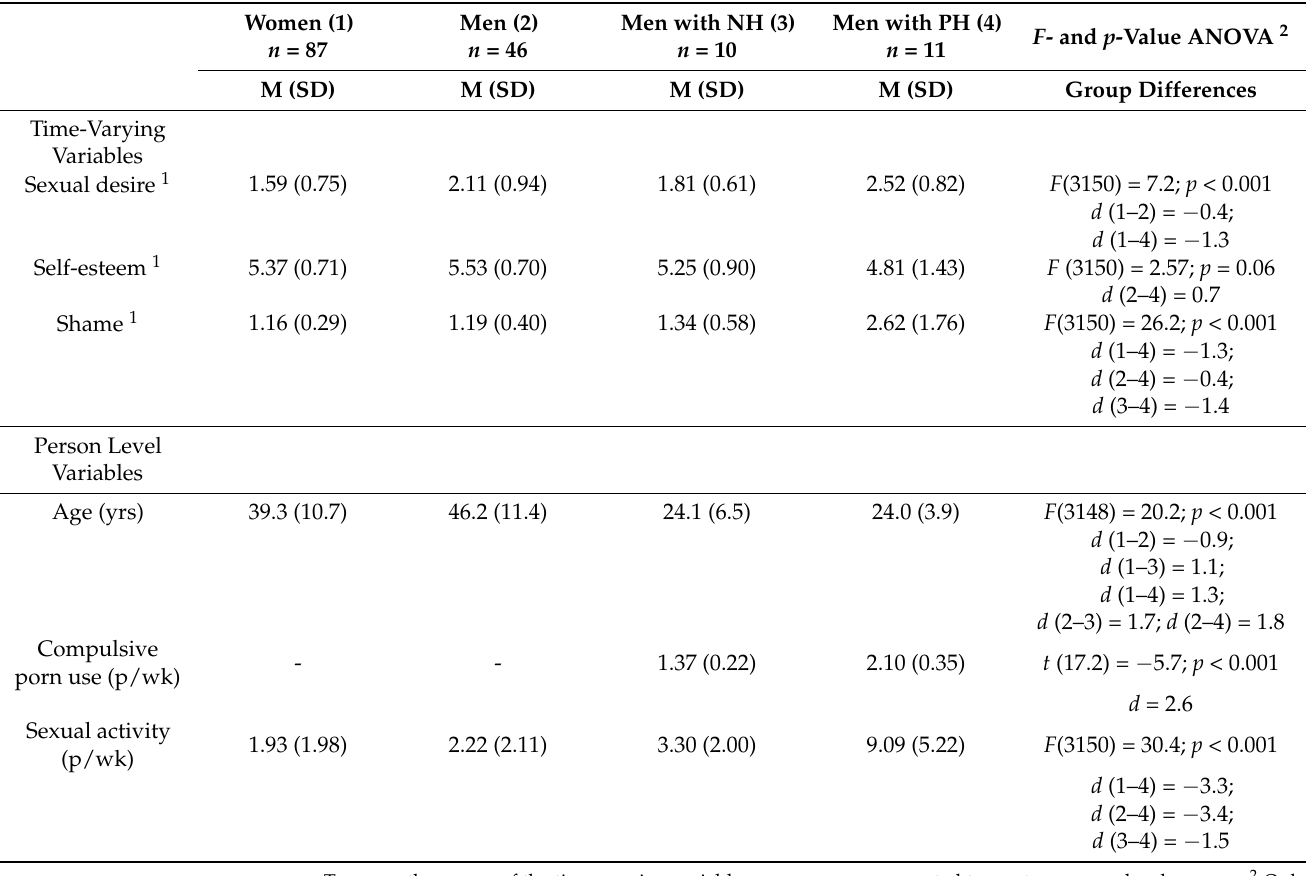
Table 2. Means and standard deviations for women, men, men with NH, and men with PH. ANOVA tests with significant post-hoc results (effect size d) are